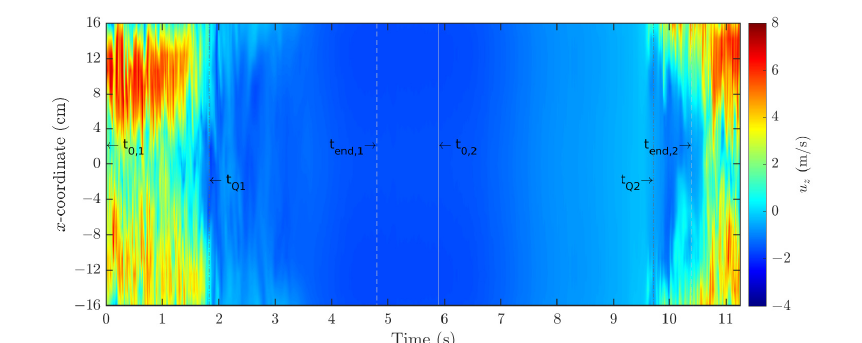
Figure 11. Contour of axial velocity at Line 2 (downstream in the preferred flow direction) during the pump mode